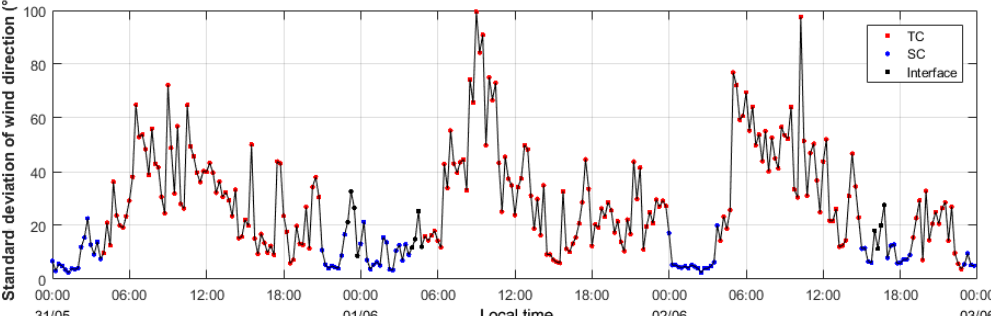
Figure 2. Standard deviation of the wind direction measured at the high-altitude site of Chacaltaya (5240ma.s.l.) from 31 May to 2 June 2012 at 1h resolution. Red points correspond to turbulent-condition (TC) cases, blue points to stable-condition (SC) cases and black points to undefined or interface cases. Time corresponds to the local time.